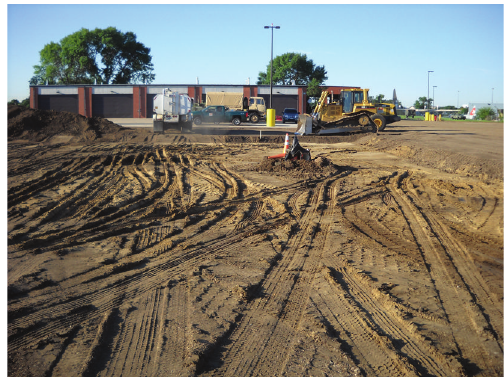
Figure 3: Photo showing typical rutting observed following proof rolling of the existing subgrade.